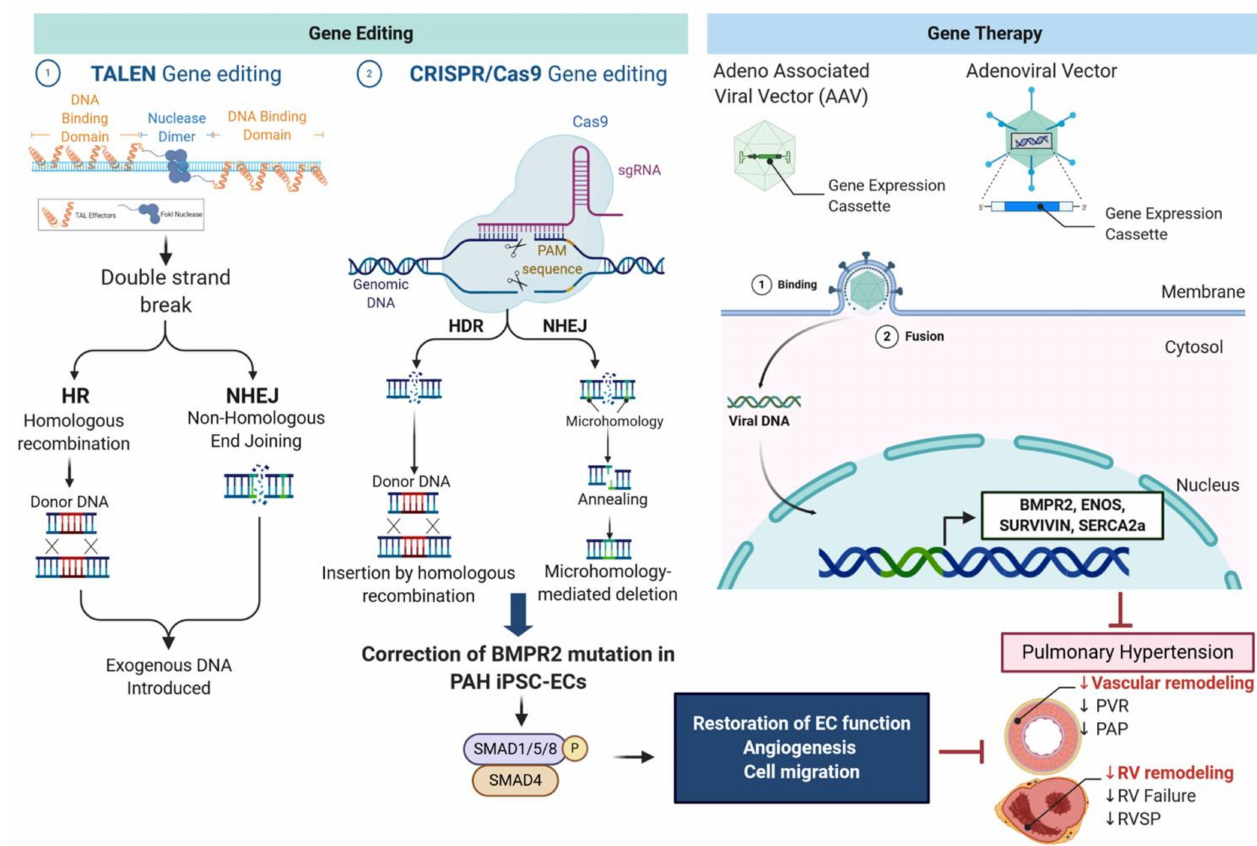
Figure 2. Therapeutic potential of genomic medicines and gene therapy in PAH. Nowadays, gene-based therapies are considered as transformative medicines. Among the most common, gene editing and gene replacement therapy are two powerful tools used to precisely edit genomes or deliver a working copy of the missing or defective. Gene editing- strategies include TALEN and CRISPR technology. Both rely on site-specific cleavage and subsequent gene editing through the cell’s DNA repair machinery by Homologous Recombination (HR) or Non-Homologous End Joining (NHEJ). Importantly, the gRNA provides the DNA repair template and allows the replacement of an existing segment. Gene therapy aims to restore BMPR2, eNOS, Survivin, and SERCA2a expression and ultimately inhibits the vascular and cardiac remodeling while improving the hemodynamic parameters in rodent models of PAH. Adeno-associated viruses (AAV); Bone morphogenetic protein receptor type 2 (BMPR2); CRISPR associated protein 9 (Cas9); Clustered Regularly Interspaced Short Palindromic Repeats (CRISPR); single guide RNA (sgRNA); Sarcoplasmic/endoplasmic reticulum Ca2+ ATPase 2a (SERCA2a); Transcription activator-like effector nucleases